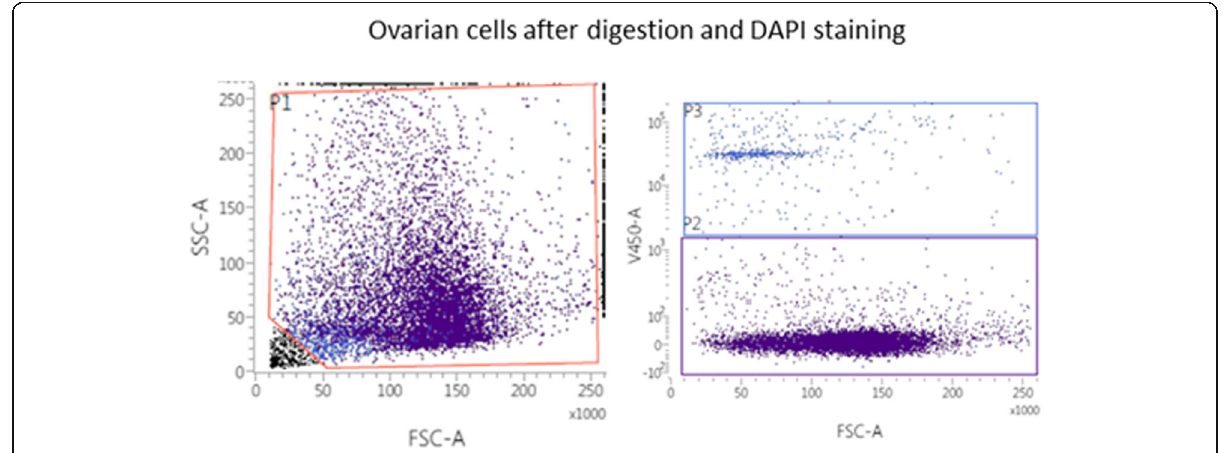
Fig. 1 Ovarian cells after digestion and DAPI